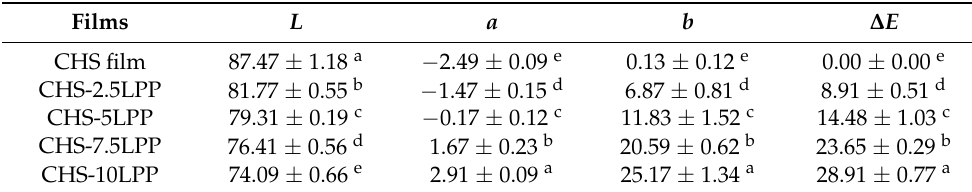
Table 1. L , a , b , and ∆ E of the films.